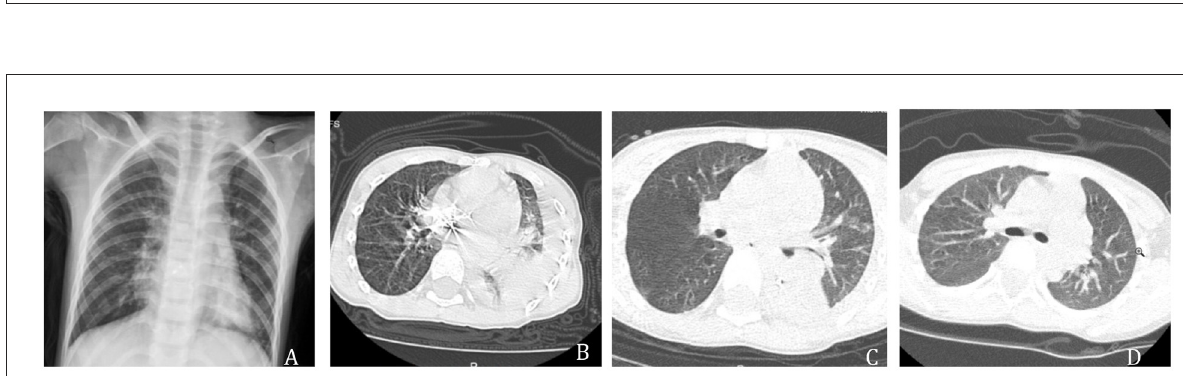
carbon dioxide 41.60 mmHg, partial pressure of oxygen 45.70 classification. Pleural fluid Mycoplasma pneumoniae DNA test resulted negative for Mycoplasma pneumoniae DNA. Chest fluid tuberculosis smear examination showed no antacid Bacilli were detected in the smear. Pleural fluid Xpert MTB/RIF showed that no Mycobacterium tuberculosis complex group was